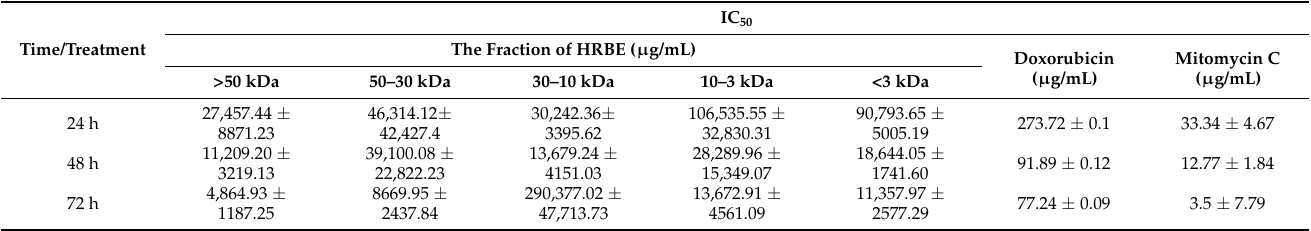
Table 3. IC 50 values of HRBE fractions, doxorubicin and mitomycin C for 24 h, 48 h and 72